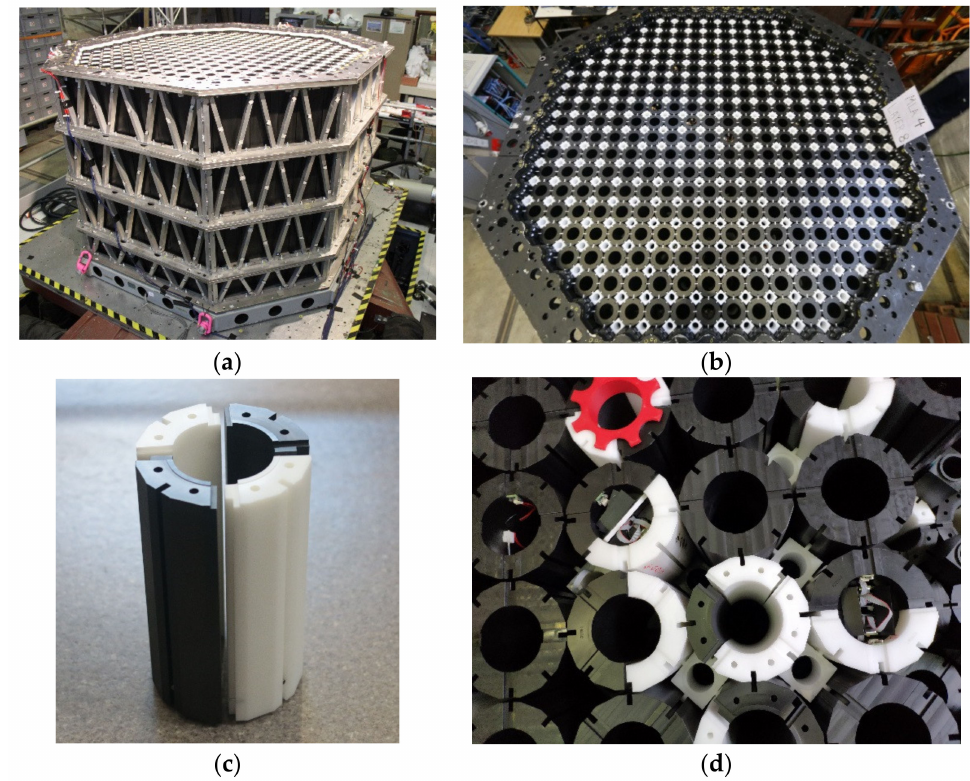
Figure 1. Multi-Layer Array rig and bricks: ( a ) Side view of MLA; ( b ) Top view of MLA; ( c ): A Quadruply Cracked Brick (QCB); ( d ) Detail of partially built MLA with intact, DCB, TCB, and QCB bricks, QCB brick held closed by red “spider”